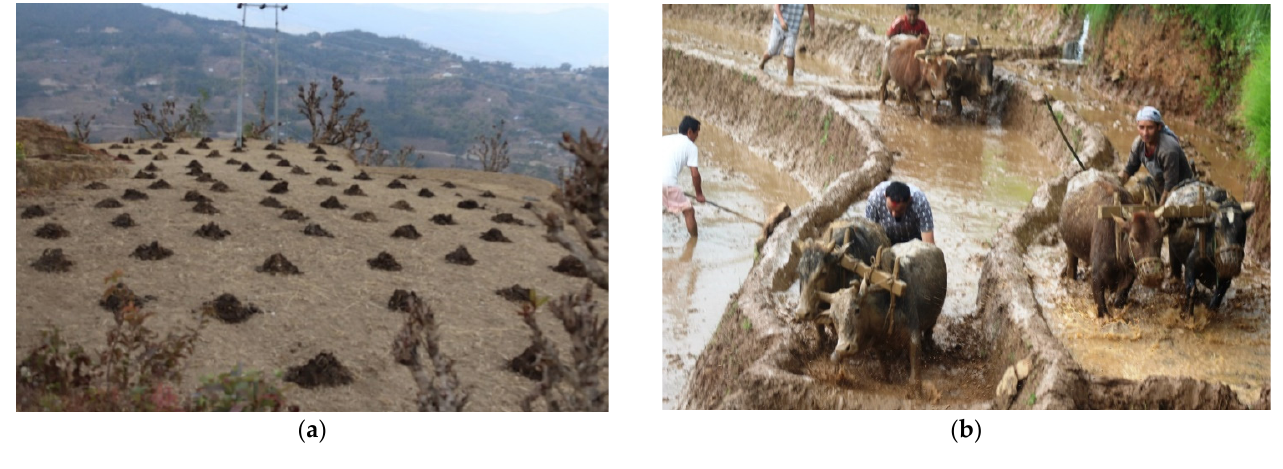
Figure 5. Indigenous farming system: ( a ) Livestock manure applied to restore organic manure lost from slope terrains. ( b ) Livestock for field plowing. The lopped branchlets of the trees around the field fed to livestock (Source: Yuba Raj Bista and Bhojpur newspaper).